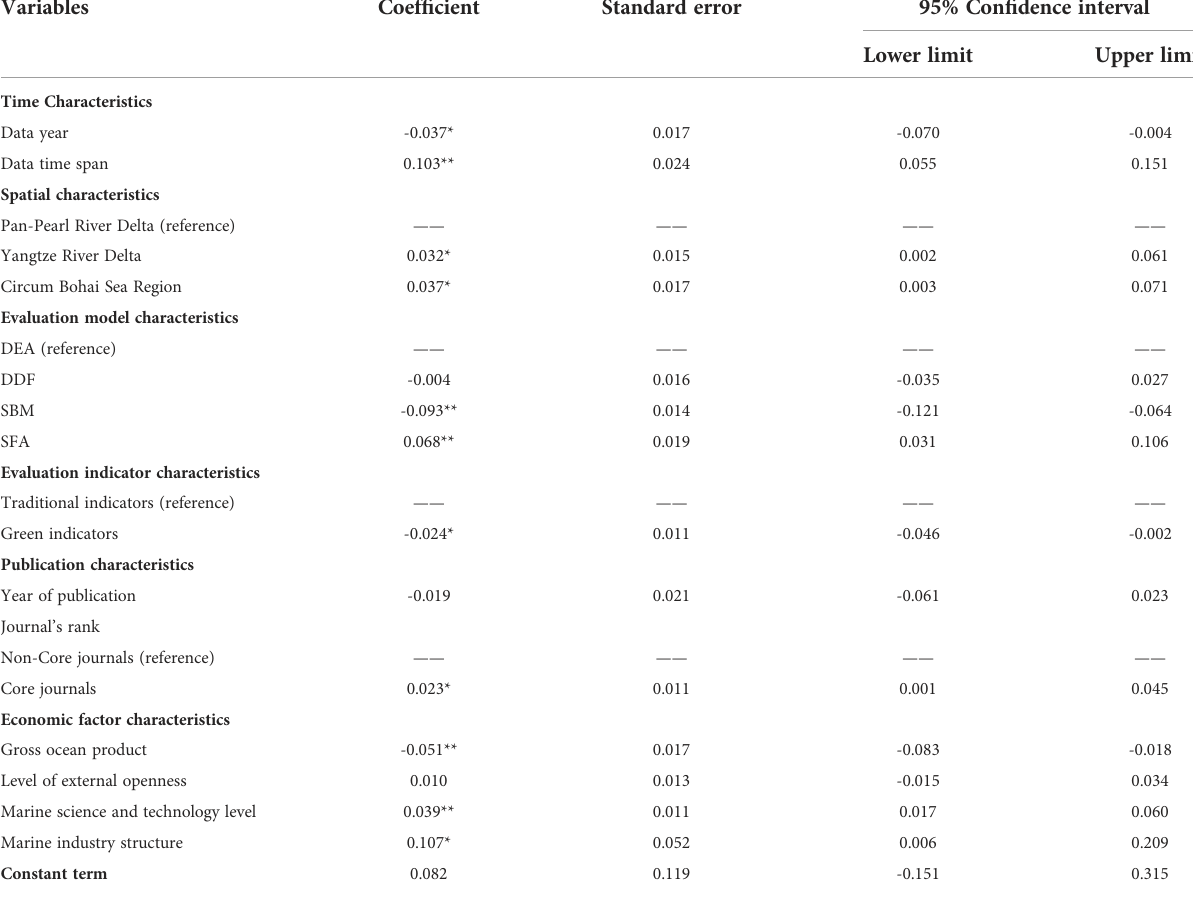
TABLE 6 The meta-regression results at the provincial